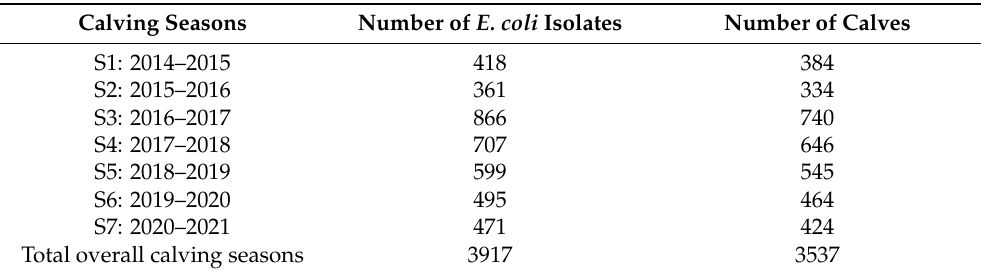
Table 1. Number of Escherichia coli isolates analysed per calving season and the associated number of calves. Calving Seasons Number of E. coli Isolates Number of